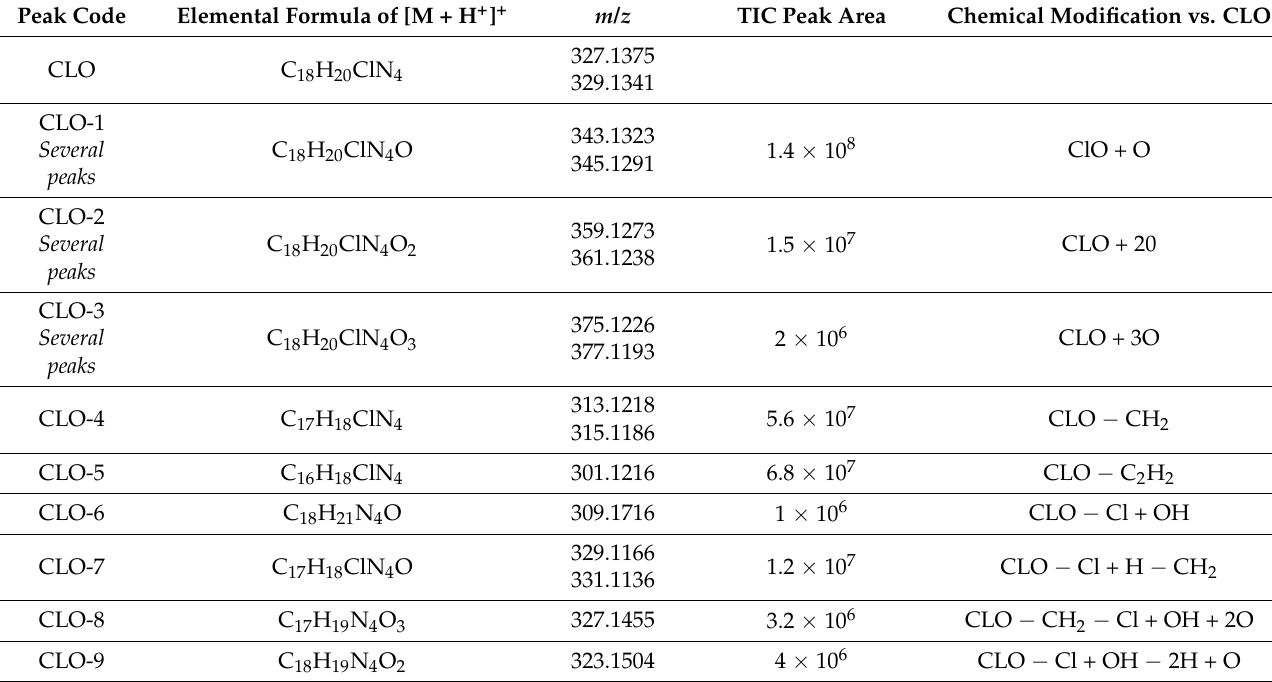
Table 2. HR-MS data of the main photoproducts of CLO after 8 h of irradiation in the presence of WEOM. Percentage of conversion = 44%.